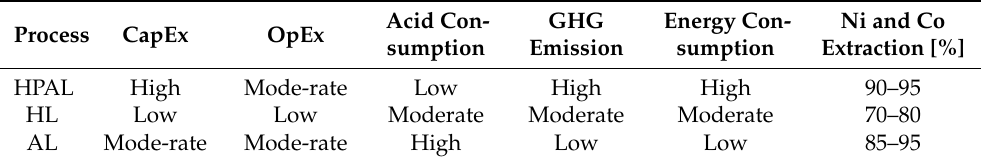
Table 3. Comparison of hydrometallurgical technologies for extraction of Ni and Co from lateritic ores that have been applied on an industrial scale